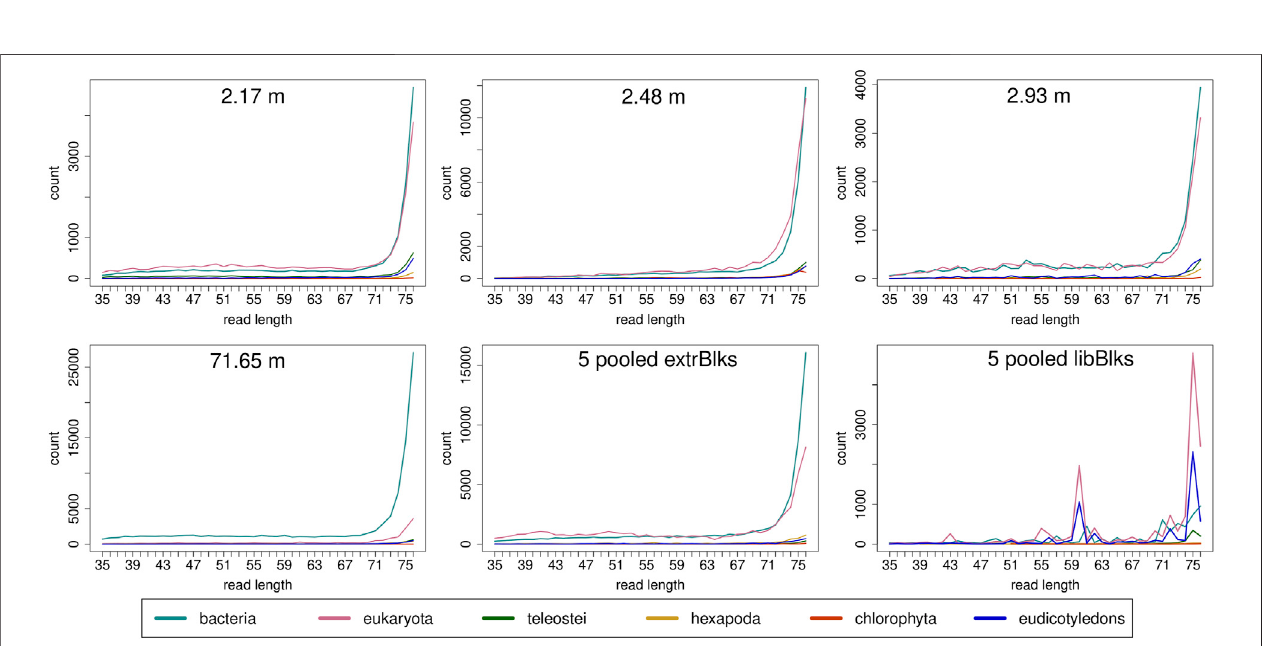
FIGURE 5 | Read length distribution of reads assigned to selected taxonomic groups after Kraken2 analysis for second round capture data. In all samples, except for the sample at 71.65 m, for some read length classes, putative eukaryotic reads are found in higher numbers than putative bacterial reads. Note that the read length distributionforthepoolofextractionblanksresemblesthoseofthesamples,especiallyoftheoldestsampleat71.65 m,withaparticularlargebacterialfraction.Theread length distribution in the pooled library blanks, however, deviates more from those of the samples and displays large frequency changes among adjacent length